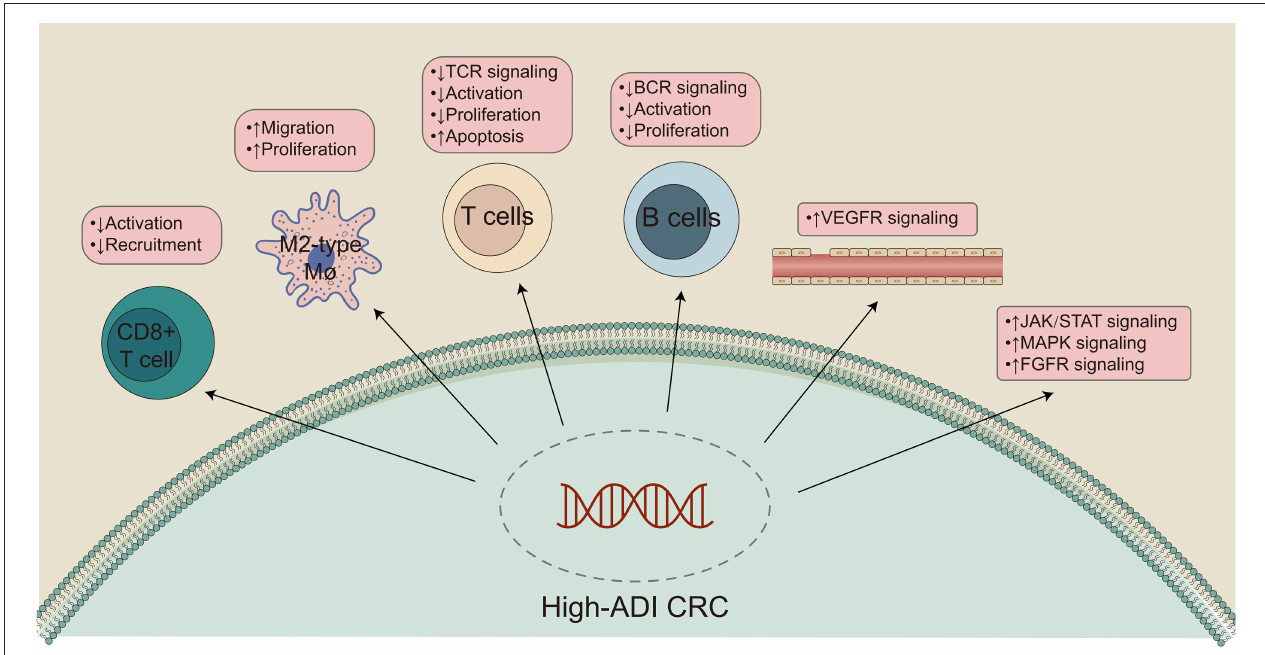
FIGURE 7 | Potential mechanism underlying the prognostic value of